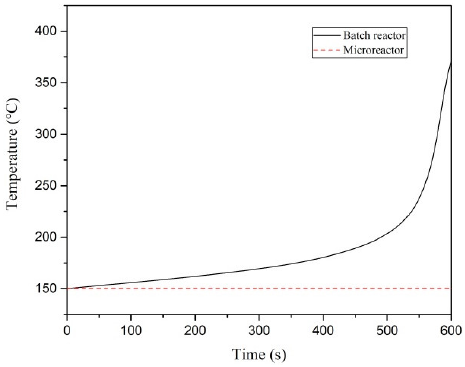
Figure 5. Temperature–time curves of the batch reactor and microreactor. Processes 2020 , 8 , x FOR PEER REVIEW